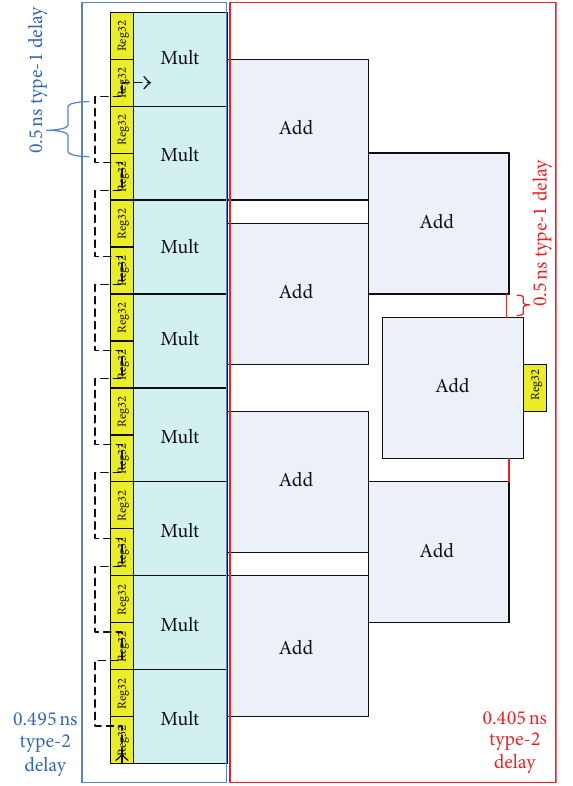
Figure 11: Type-1 and type-2 delays of 8-tap FIR filter on Virtex-4